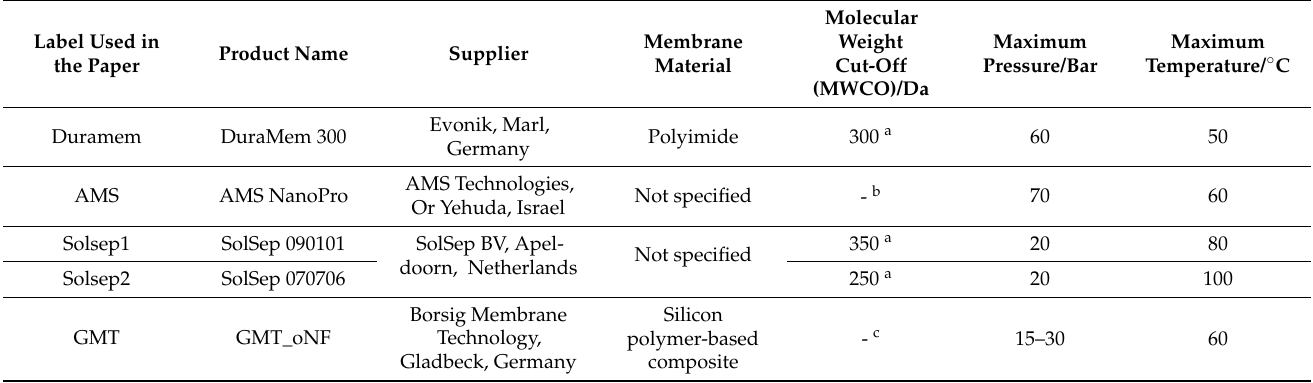
Table 2. List of OSN membranes used within this work with supplier, membrane material, molecular weight cut-off (MWCO), maximum operating pressure, and maximum operating